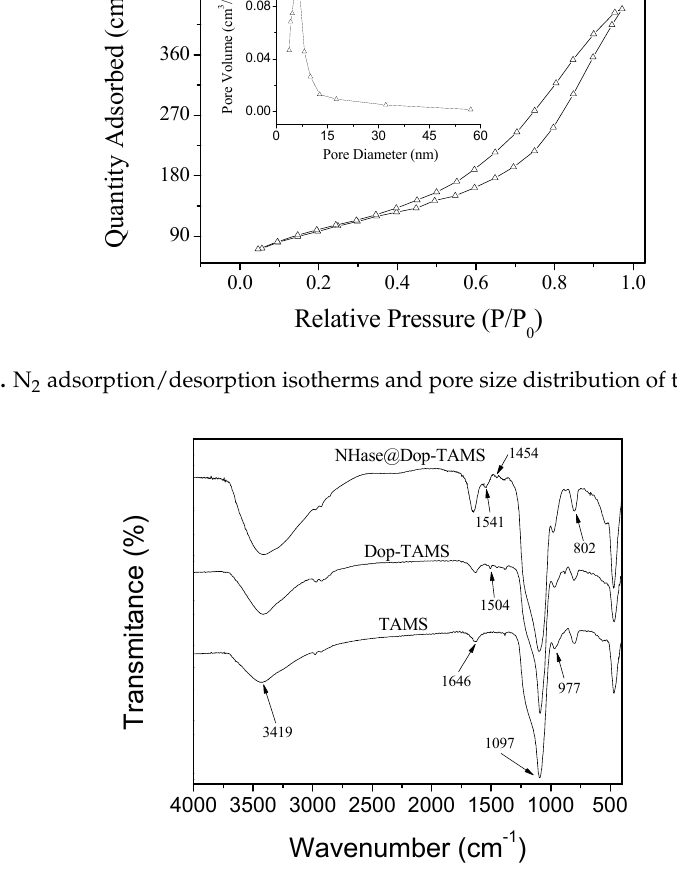
Figure 4. FT-IR spectra of the TAMS, Dop-TAMS, and NHase@Dop-TAMS.